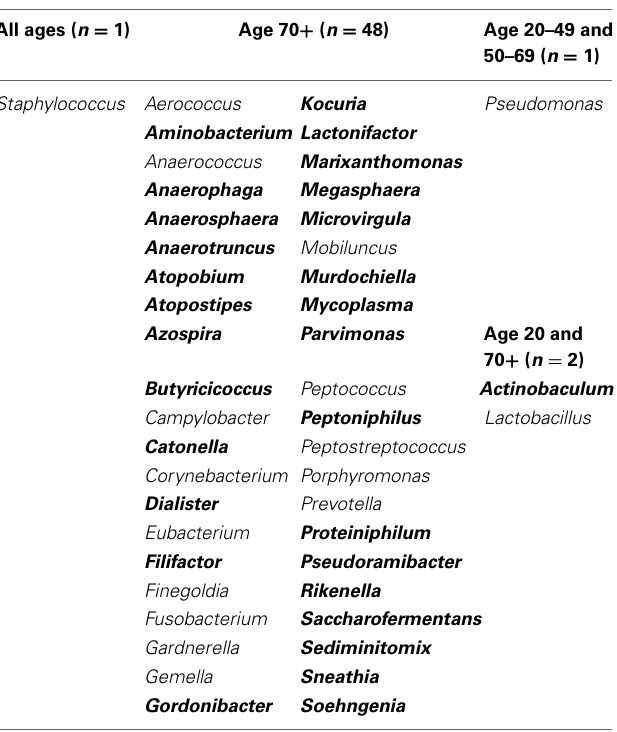
Table 3 | Table detailing the genera identified within each defined age group for males